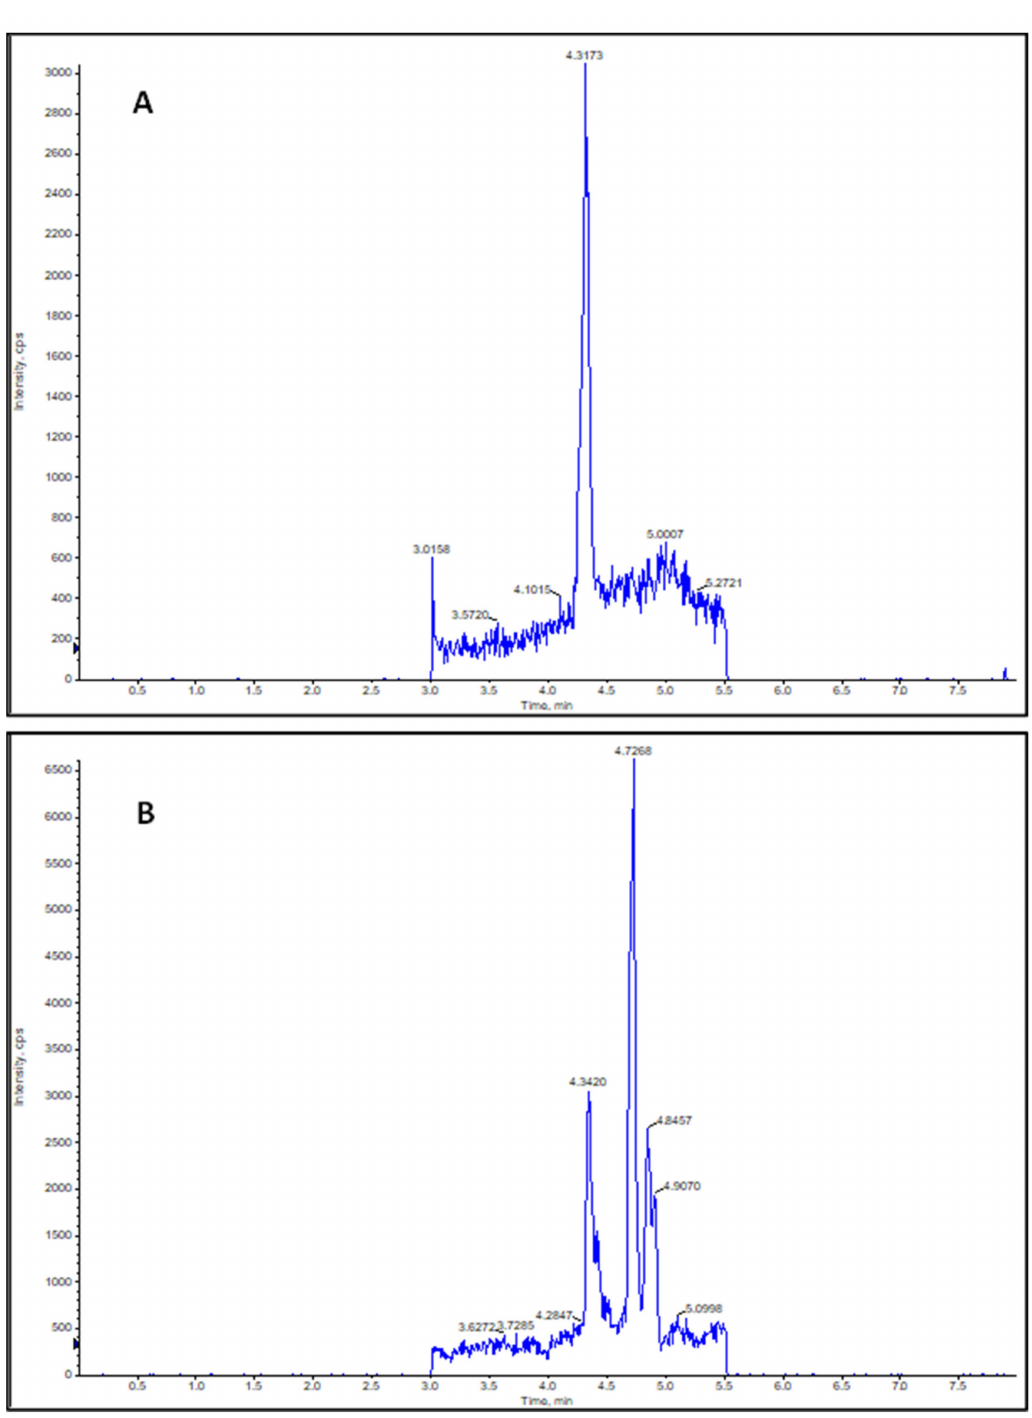
Figure 4. ( A ) Ion Chromatogram of m / z 326.5 of NO 2 -OA working solution (100 ng / mL). Peak retention time (RT) = 4.3173 min. ( B ) Ion Chromatogram of m / z 326.5 of a sample derived from 7- day- old Brassica napus seedlings. Peak retention time (RT) = 4.3420